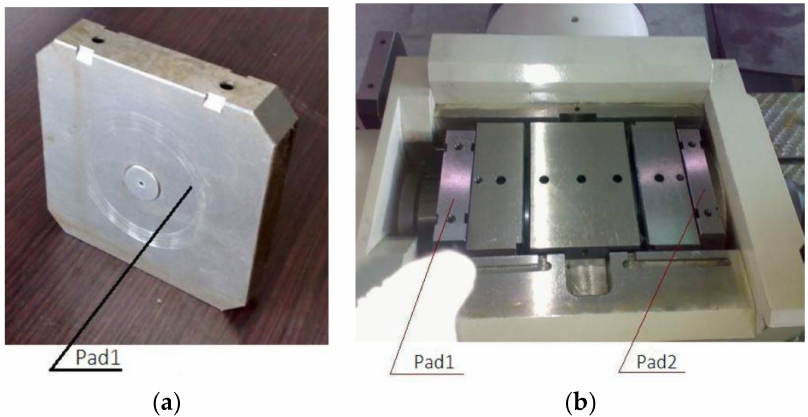
Figure 10. ( a ) The pad; ( b ) the fixed test bearings in the housing.